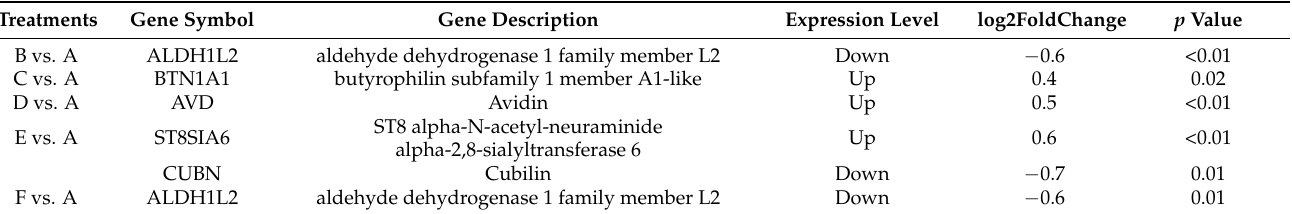
Table 2. Differentially expressed genes in the liver of broiler chickens as influenced by treatment groups 1